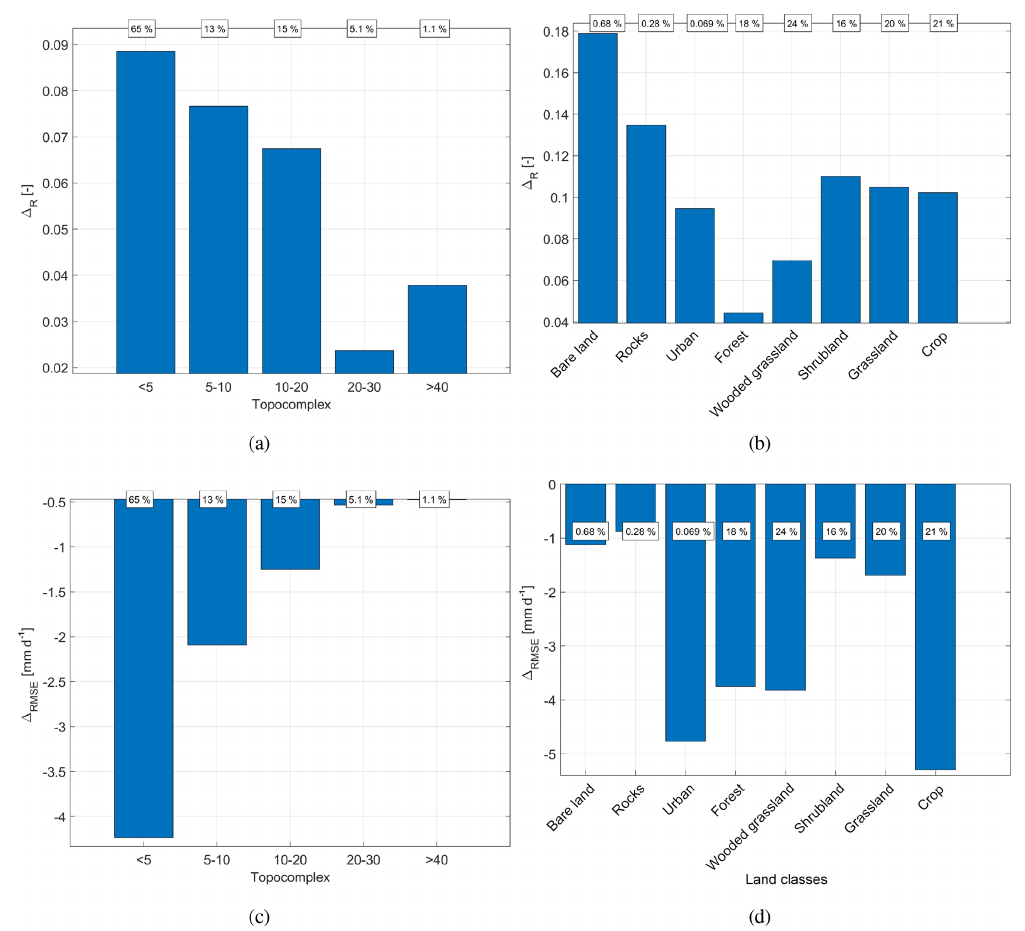
Figure 6. Difference in median correlation ( (cid:49) R ) and in median root mean square error ( (cid:49) RMSE ) between the integrated product P R + SM and IMERG-ER as a function of the topographic complexity (a, c) and as a function of the land cover type (b, d) over CONUS. The results refer to the 2015–2017 period. The text boxes on the top show the percentage of the area occupied by the specific topographic complexity or land cover